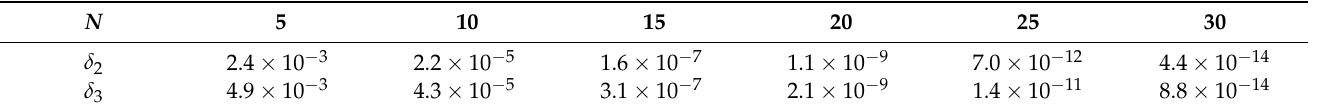
Table 2. Relative errors of expressions